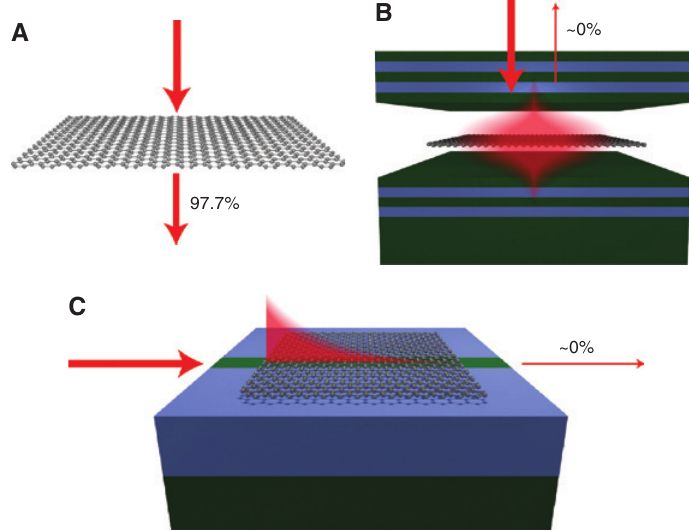
Figure 1: Various configurations for light-matter interaction in 2D materials. (A) Normal incident light has the advantage of broadband absorption, but very small total absorption. (B) Absorption can be enhanced by placing a 2D material inside an optical resonator to enhance light-mater interaction. This enhances absorption but limits the optical bandwidth of the device. (C) Waveguide integration of 2D materials overcomes both limitations by providing a platform that increases the interaction length while maintaining broad optical